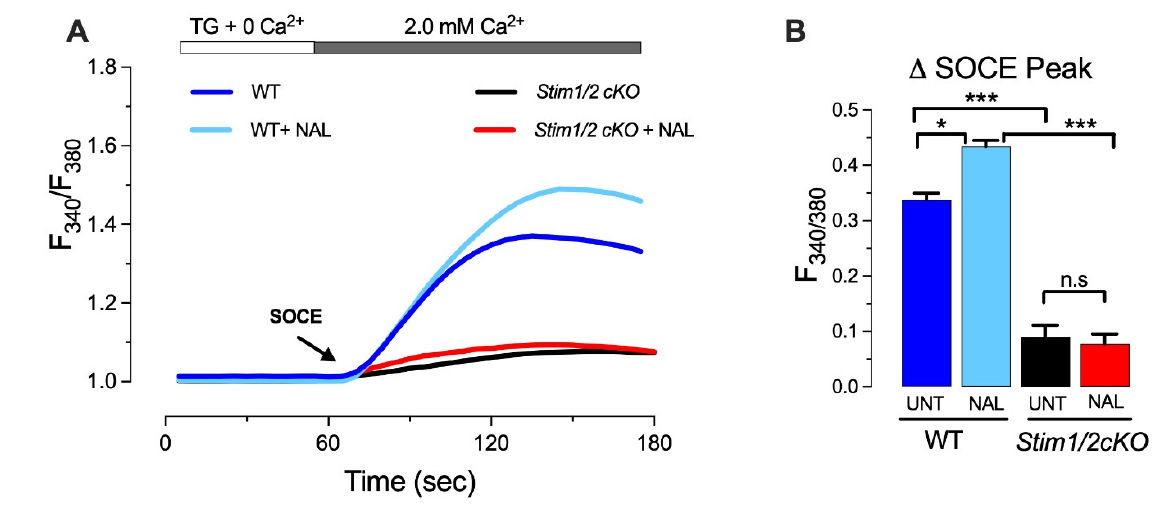
Figure 2. TRPM7 stimulation does not elicit Ca 2+ influx in SOCE-deficient ameloblasts . ( A ) Representative original traces of [Ca 2+ ] cyt transients in ameloblasts of Stim1/2 K14cre mice ( Stim1/2cKO ) and controls (WT) ameloblasts. The ameloblasts of Stim1/2 K14cre mice were isolated as reported (28). SOCE was measured after pre ‐ incubation with thapsigargin (20 min, 1 μ M), followed by perfusion with a Ca 2+ ‐ free Ringer’s solution (60 s) before simultaneous re ‐ addition of 2.0 mM extracellular Ca 2+ or with 2 mM Ca 2+ and the TRPM7 agonist naltriben (NAL,100 μ M). ( B ) Quantification of the SOCE peak. Data were analyzed by one ‐ way ANOVA followed by Tukey’s multiple comparison post ‐ hoc test. * p < 0.05, *** p < 0.001, n.s., non ‐ significant.